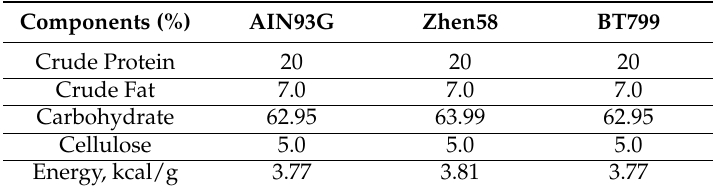
Table 2. Nutritional composition of